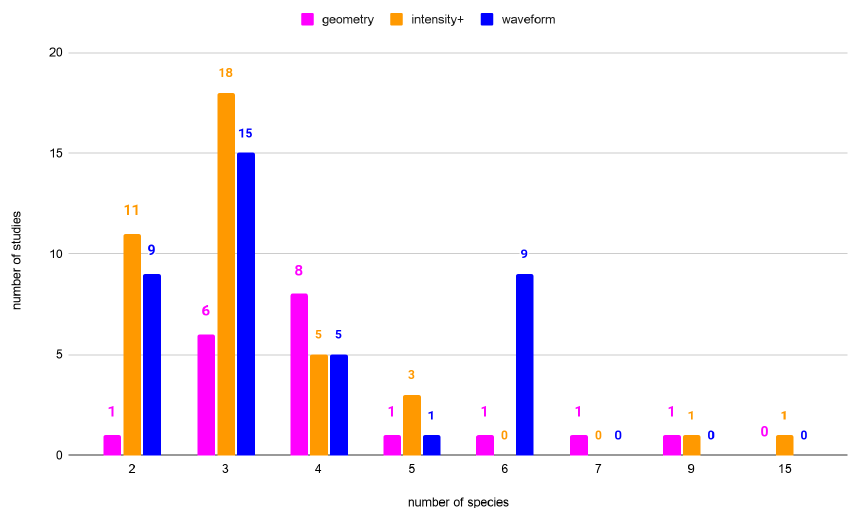
Figure 2. The number of conducted studies with division into feature groups ( geometry , intensity+ , waveform ) used to classify a specified number of species.